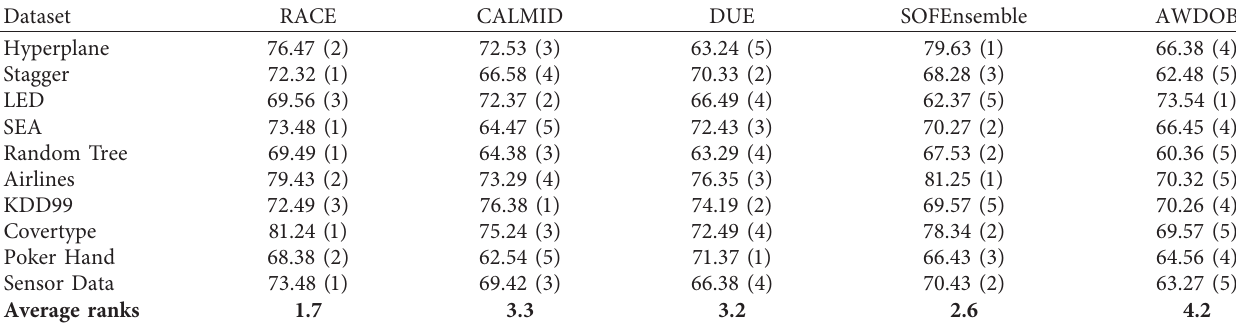
Table 7: Prediction accuracy of the algorithms using Hidden Markov Models.